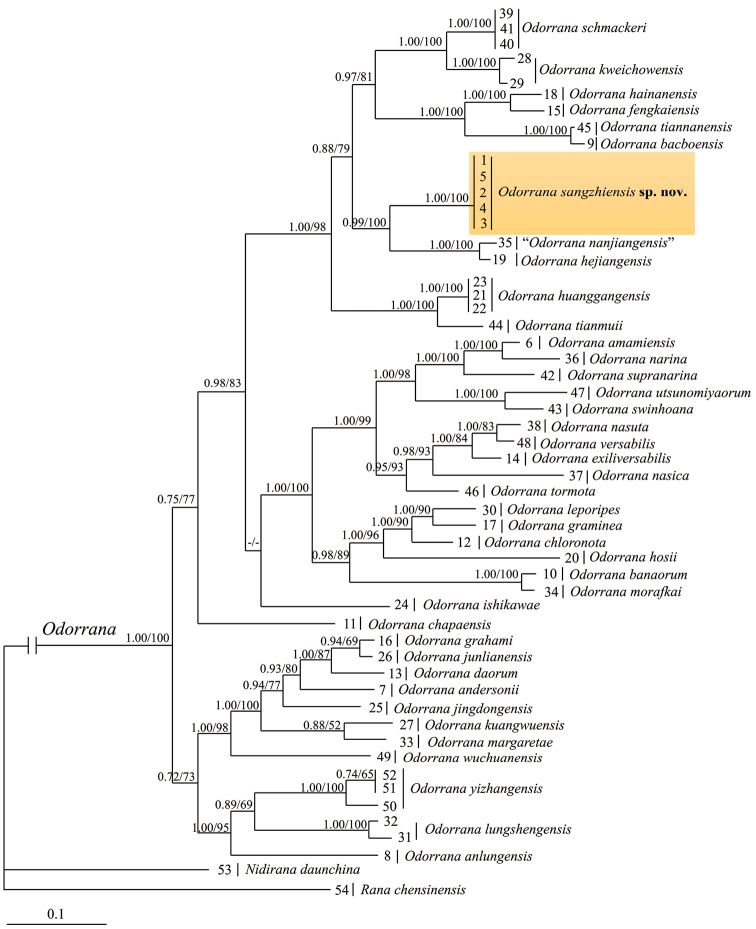
Bayesian Inference tree based on the partial DNA sequences of the mitochondrial 12S and 16S genes. Numbers before slashes indicate Bayesian posterior probabilities and numbers after slashes are bootstrap support for Maximum Likelihood (1000 replicates) analyses. The symbol “-” indicates a value below 50%.